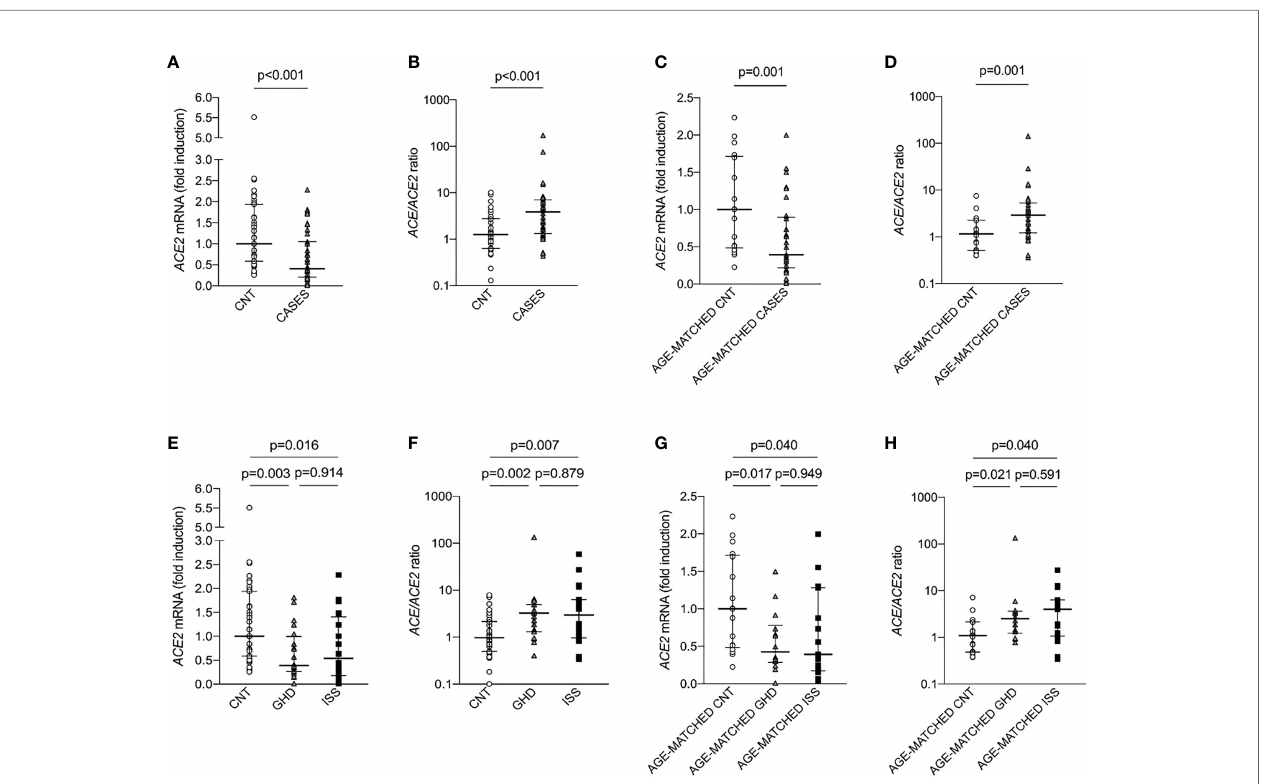
FIGURE 1 | ACE2 expression and ACE / ACE2 ratio in children with short stature (CASES) and controls (CNT). Gene expression was measured as mRNA fold induction as compared to controls (CNT). ACE is for angiotensin converting enzyme, ACE2 is for angiotensin converting enzyme 2, GHD is for growth hormone de fi ciency and ISS is for idiopathic short stature. (A – D) Mann-Whitney test, (E – H) Kruskall-Wallis